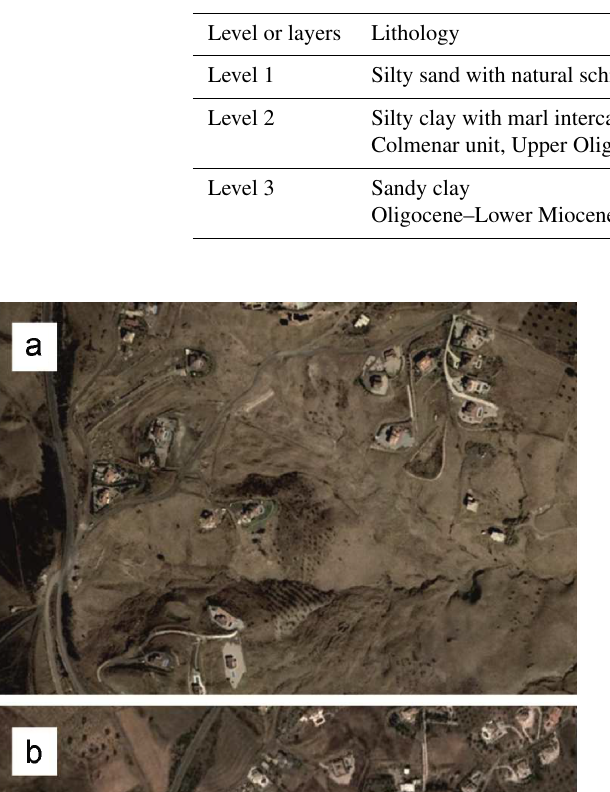
Table 1. Lithology of the area affected by the failure, according to the laboratory tests of Geolen S.A. No groundwater level was detected.